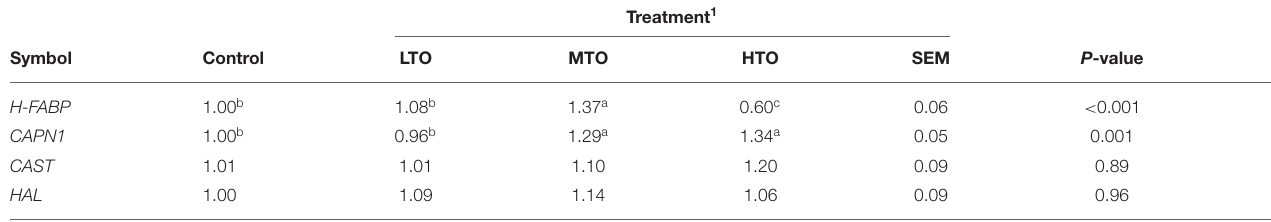
TABLE 9 | Effects of TTO supplementation on the genes expression of H-FABP, CAPN1, CAST, and HAL in Longissimus dorsi muscle in the finishing pigs ( n = 6). Treatment